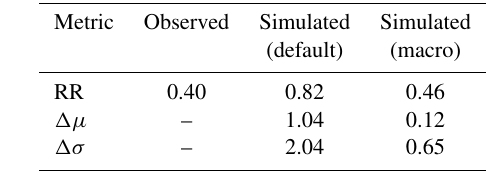
Table 4. Comparison between observed and simulated daily aver- age runoff from the two configurations over the Kennet catchment. Metrics include the runoff ratio (RR), relative bias ( (cid:49)µ ), and rel- ative difference in standard deviation ( (cid:49)σ ) (refer to the Appendix for further